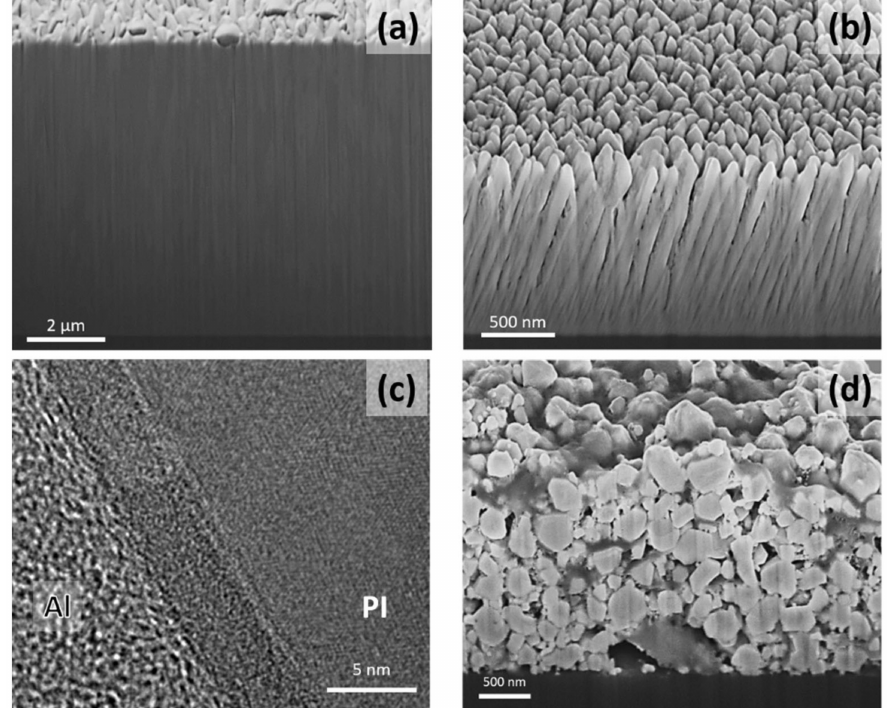
Figure 1. Cross-sections of thin films. ( a ) SEM micrograph illustrating the fine-columnar growth with columns perpendicular to the substrate surface of a film with a composition of Mo 0.72 Al 0.17 Ti 0.11 deposited directly in front of a rotatable Mo 0.70 Al 0.20 Ti 0.10 target and ( b ) the open-voided columnar growth of a film grown from the same target and using the same deposition parameters under inclined conditions resulting in a composition of Mo 0.67 Al 0.23 Ti 0.10 [19]. ( c ) Transmission electron microscopy cross-section of an Al film thermally evaporated on a polyimide (PI) substrate, clearly indicating the modified near surface zone formed during film deposition (courtesy of B. Putz,